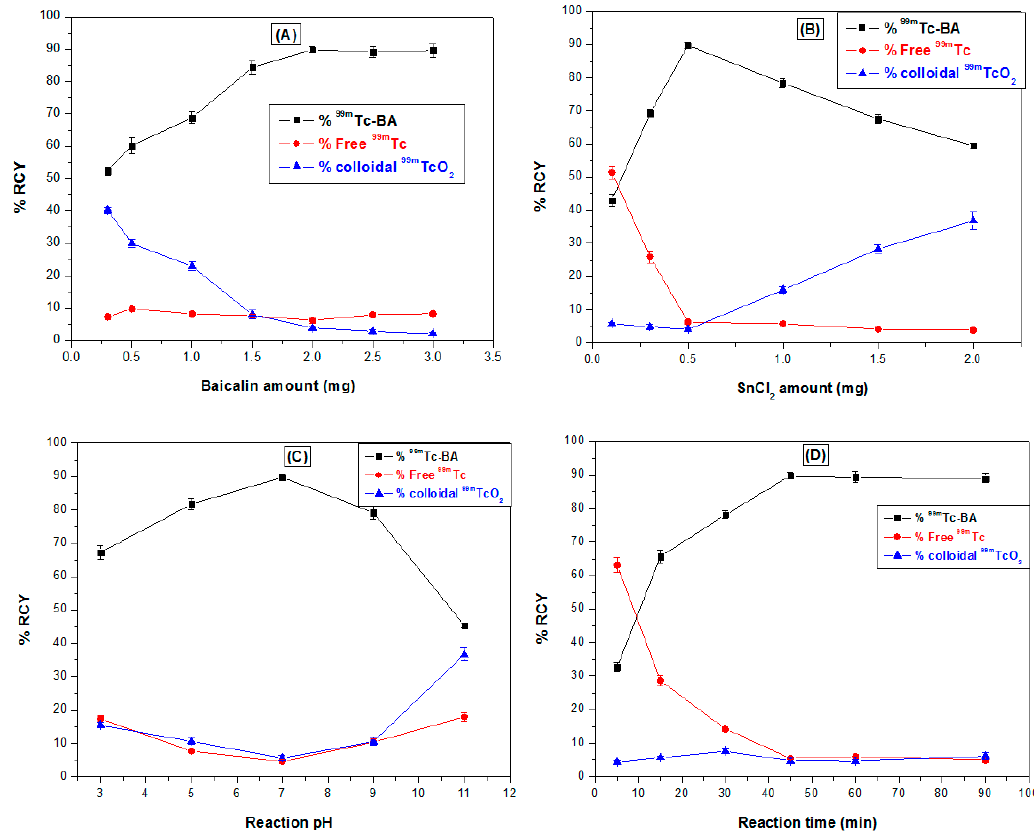
Figure 7. E ff ect of di ff erent labelling conditions on the percentage radiochemical yield (% RCY) of 99m Tc-BA complex. ( a ) BA amount, ( b ) SnCl 2 amount, ( c ) reaction pH and ( d ) reaction